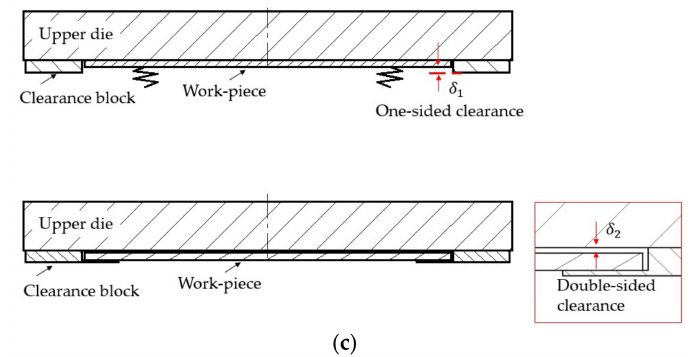
Figure 2. Experimental set-up of in-die quenching: ( a ) test rig dimensions (all dimensions are in mm); ( b ) in-die quenching test rig; and ( c ) schematic of die clearance